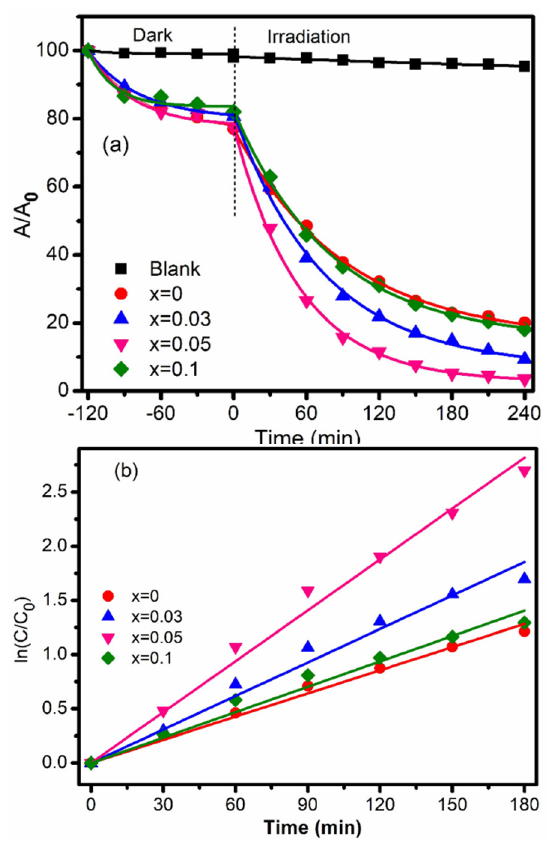
Figure 7. ( a ) Photocatalytic activities for the degradation of 10 ppm 2-naphthol and ( b ) pseudo- first-order kinetics cure of Sr 1 − x La x TiO 3 photocatalysts. Conditions: catalyst, 0.1 g; 2-naphthol (10 ppm, 200 mL); pH 6.3; 30 °C; Exo Terra Natural Light (Repti Glo 2.0 Comp Fluor 26W PT2191-220, Illuminance: 15350 Lux, 400–700 nm). Table 4. The degradation efficiency and pseudo-first-order rate constant of Sr 1 − x La x TiO 3.